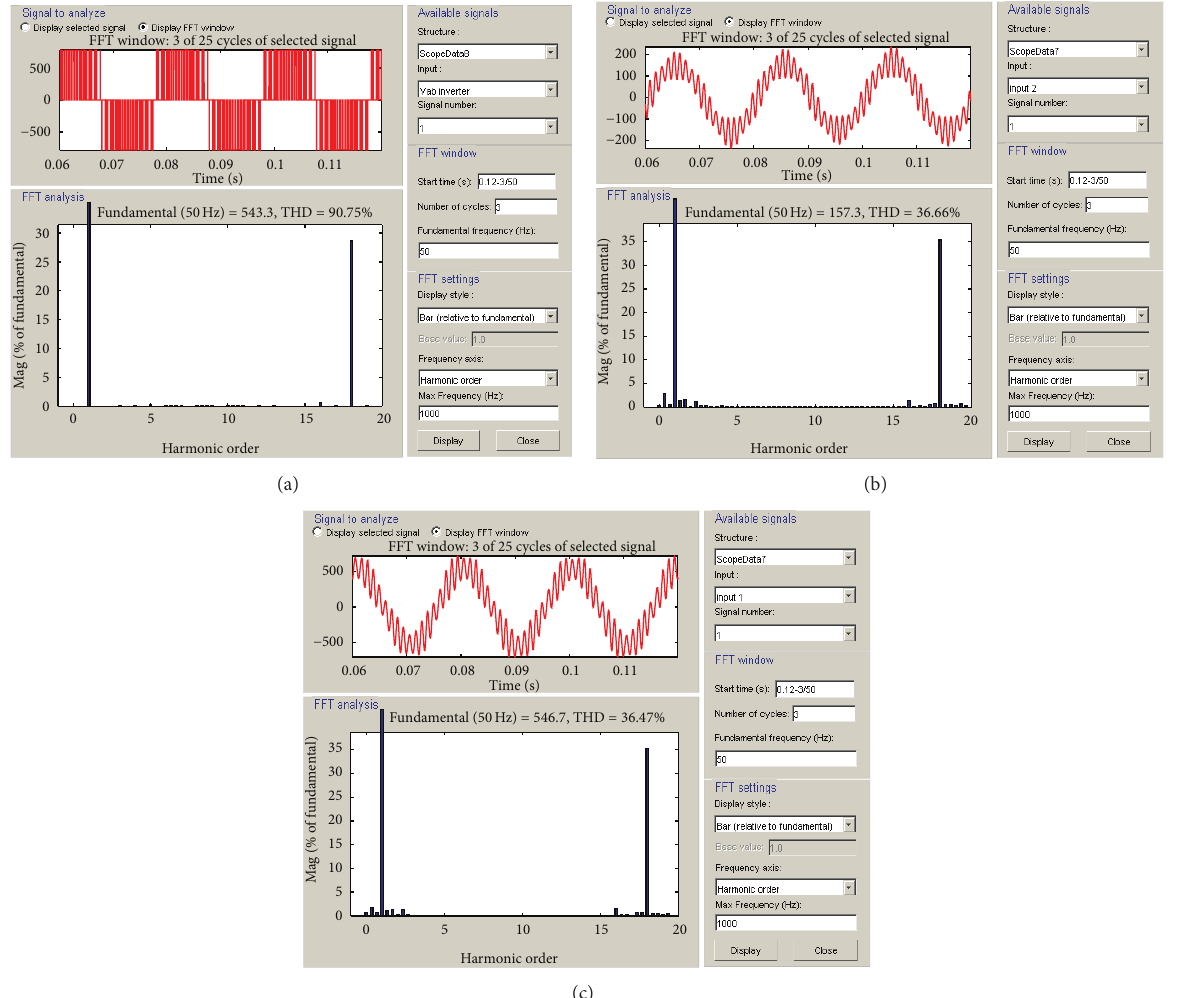
Figure 7: (a) The THD analyses of inverter voltage, (b) inverter current, and (c) the grid or load voltage at 1kHz switching